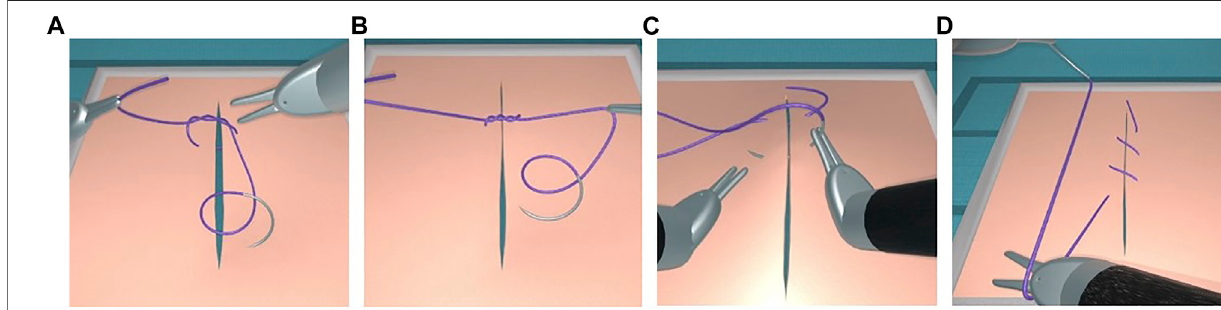
FIGURE 12 | Interrupted suturing (A,B) and continuous suturing (C,D) .